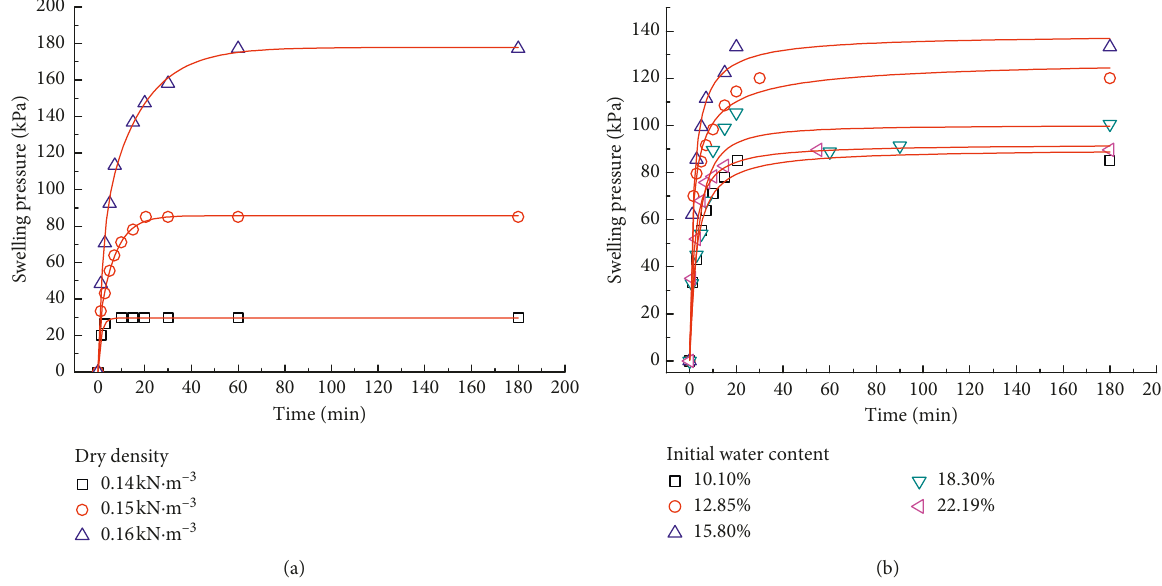
Figure 16: Relation between the swelling pressure and time. (a) Initial water content of 10.10%. (b) Dry density of 0.15kN/m 3 .